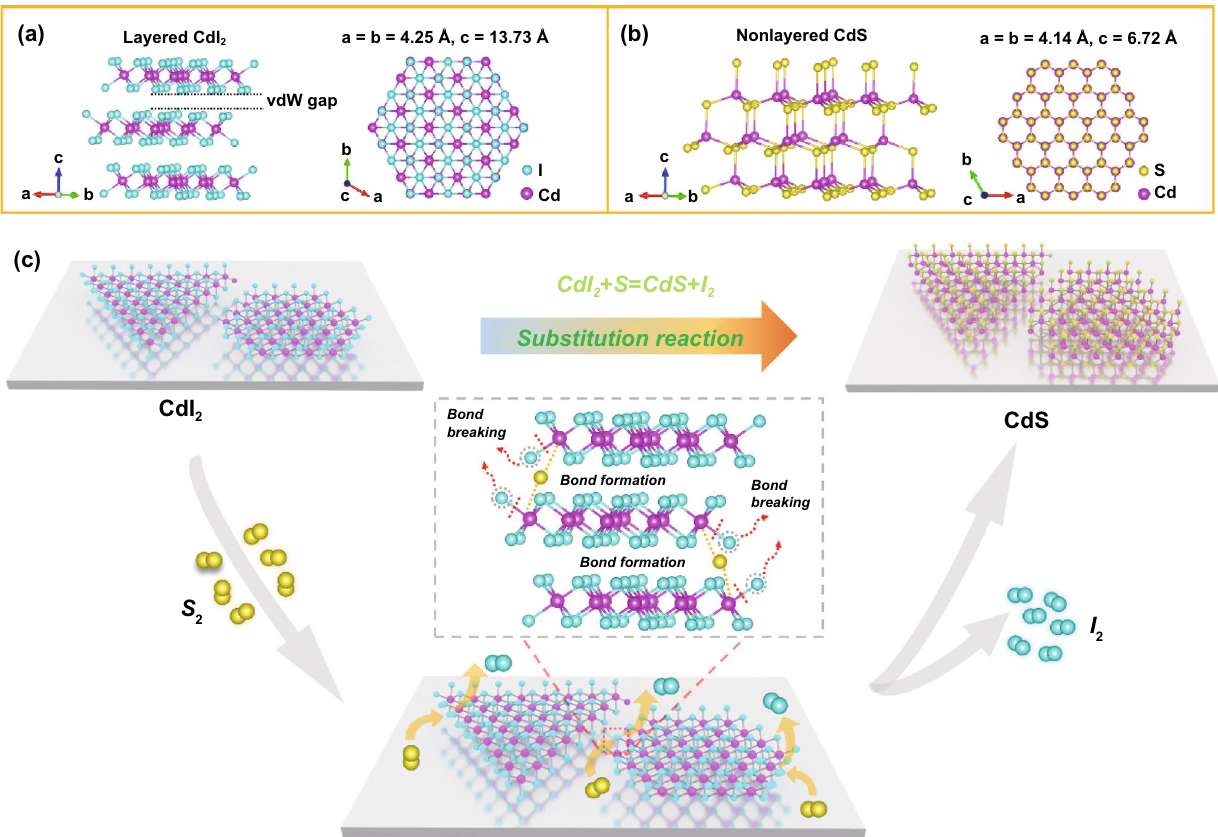
Fig. 1 Schematic illustration and synthesis process of the conversion in crystal structure from layered CdI 2 to nonlayered CdS via chemical substitution reaction by addition of S powder. a , b Crystal structure of layered CdI 2 (hexagonal) and nonlayered CdS (hexagonal), respectively. c Conversion process of CdI 2 to CdS through substitution of I atoms by S